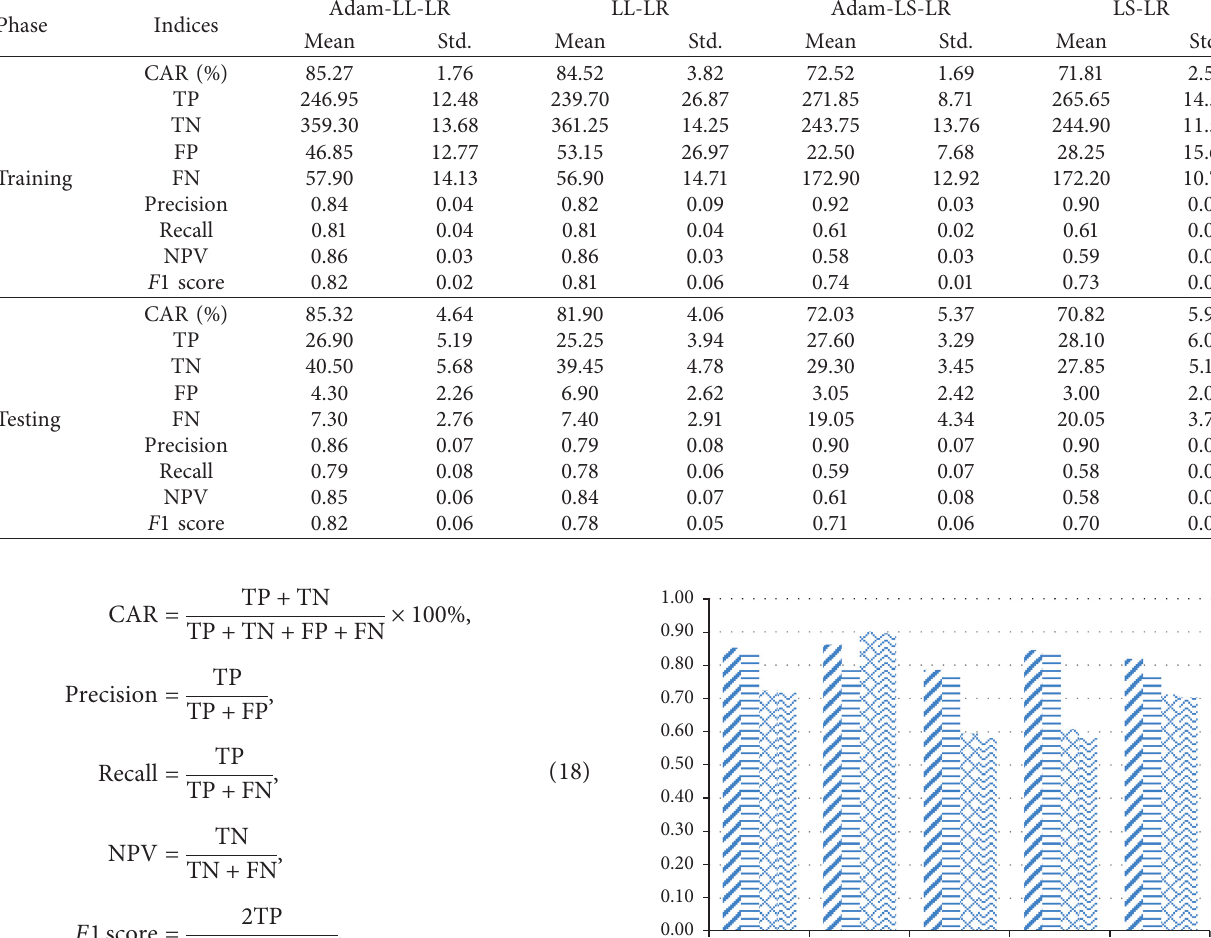
Table 2: Prediction result comparison.